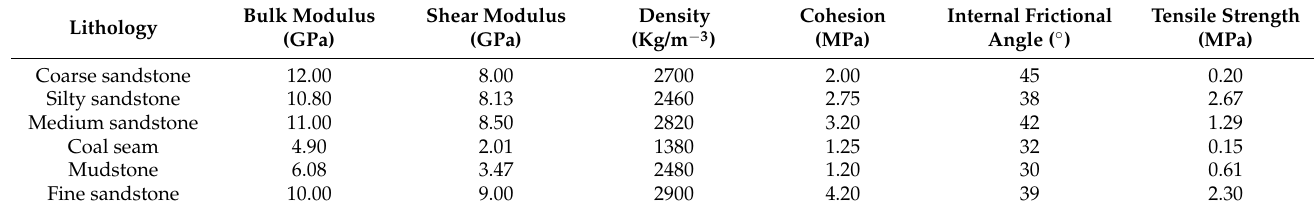
Figure 1. Numerical Model of Coal Roadway Disturbed by Dynamic Load in No.1 mining area. Table 3. Physical and Mechanical Parameters of Coal and Rock Mass.